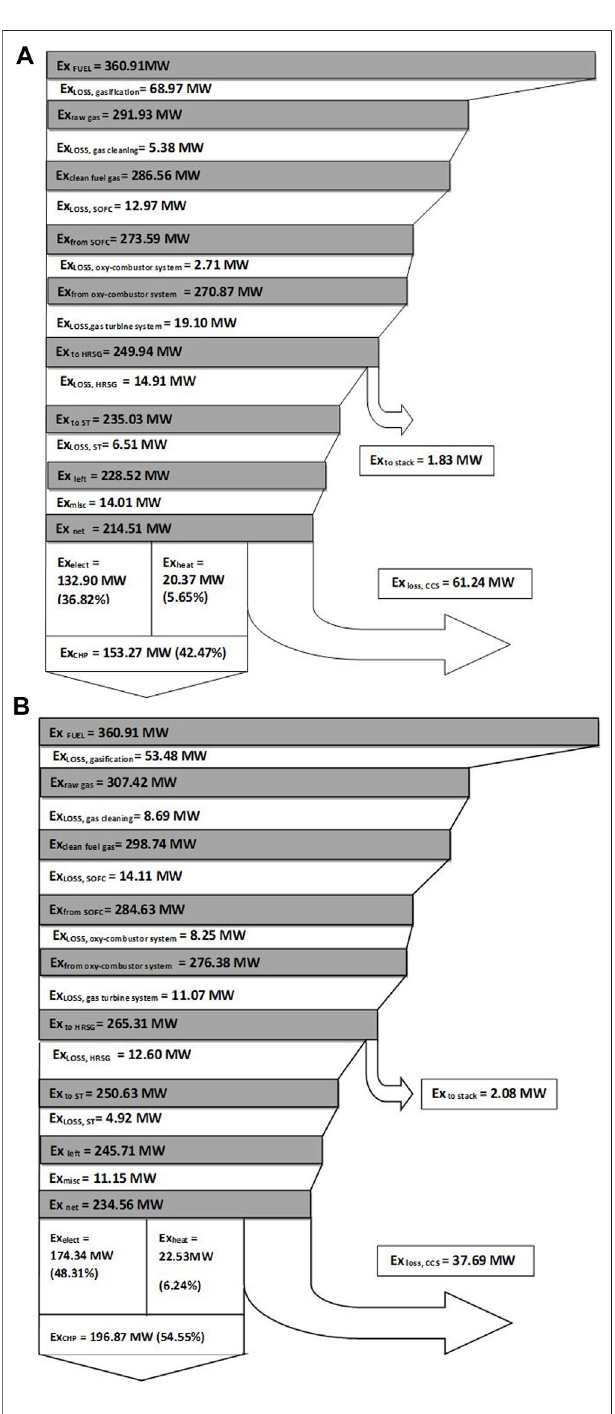
FIGURE 4 | (A) Exergy fl ow diagram for the air gasi fi cation case. (B) Exergy fl ow diagram for the steam-oxygen gasi fi cation